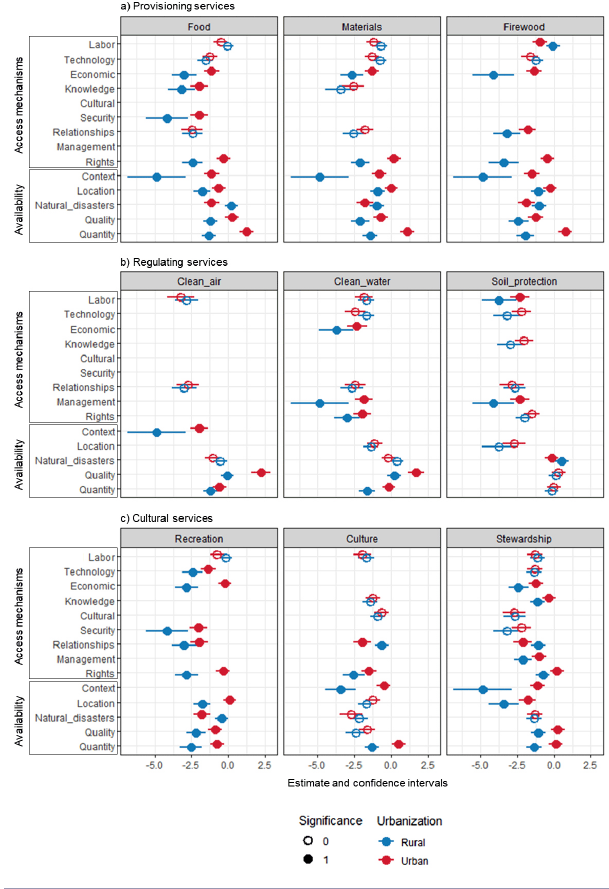
Fig. 3 . Comparison of limitations reported per ecosystem service between urban and rural dwellers for (a) provisioning, (b) regulating, and (c) cultural services. Values represent estimated marginal means with associated confidence limits from multiple comparisons following a logistic